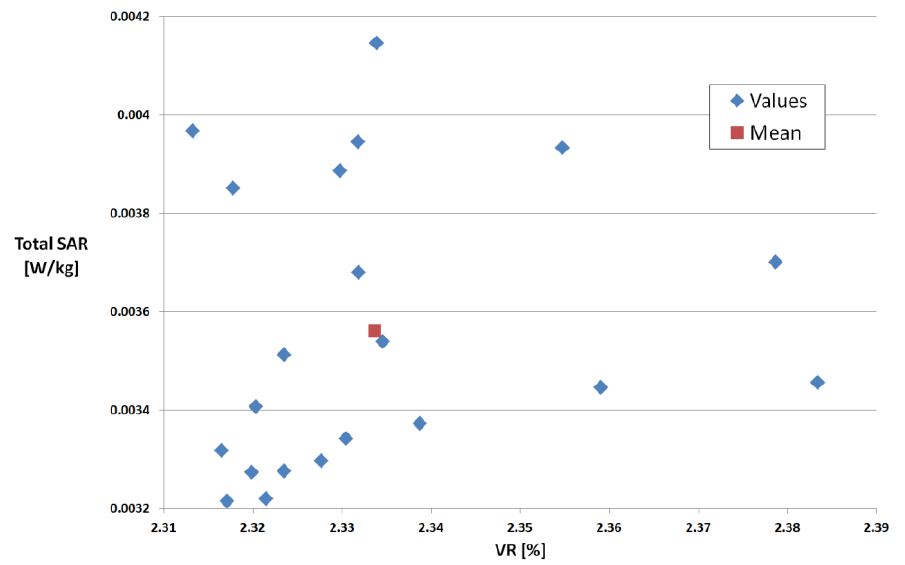
Figure 7. Results for 20 consecutive runs, TiO 2 (10%), target VR = 2.365%.